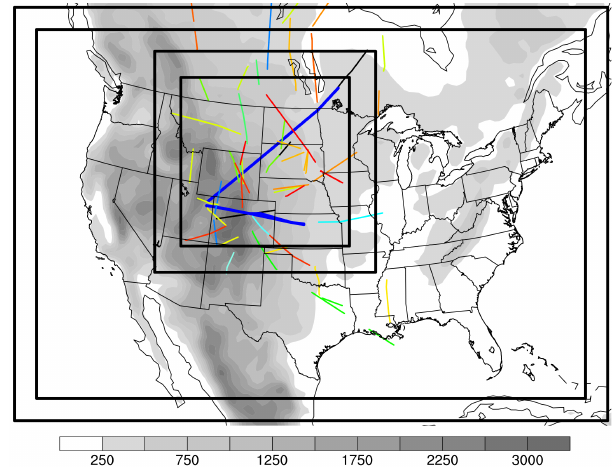
Figure 1. The 68 Gulfstream V (GV) flight segments (colored lines) selected for wave analysis during START08. The 18 colors rep- resent 18 research flight (RF) missions. The thick blue lines rep- resent the second flight (RF02). The gray shadings give the ter- rain elevation map (shaded every 250m) over North America. The four black boxes are the model domain design for the second re- search flight (RF02) during 21–22 April 2008, which are named D1–D4 from coarse to fine domain with horizontal resolutions of 45, 15, 5 and 1.67km, respectively. The field catalog of the 18 RFs are available online (at http://catalog.eol.ucar.edu/start_08/ missions/missions.html). The GV ground tracks of the 18 RFs are also documented in Fig. 2 of Pan et al.